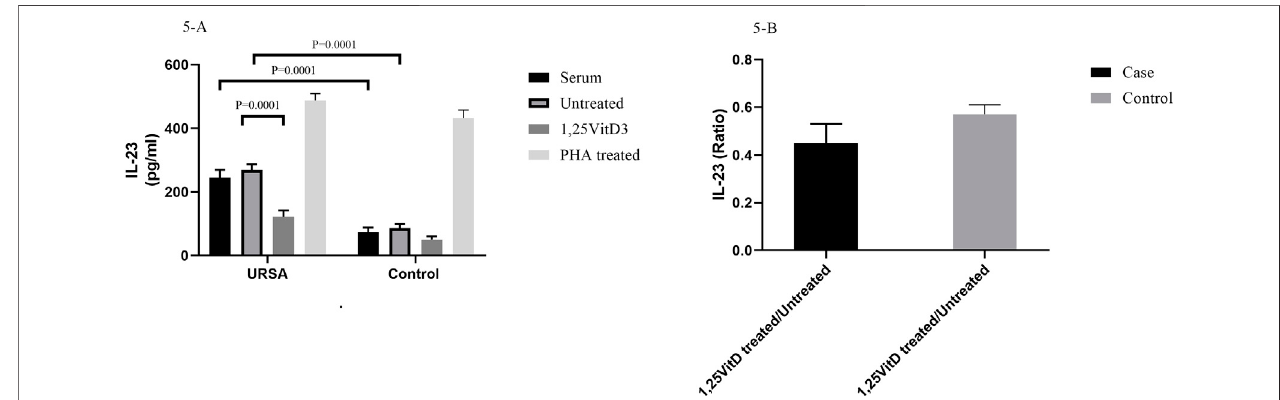
FIGURE5| IL-23levelsinserumandcellculturesupernatantsinwomenwithURSAandthecontrolgroup (A) .IL-23serumlevelswerehigherinwomenwithRSAthan in the control group. IL-23 levels were higher in cell culture supernatants in women with RSA than in the control group. 1,25VitD3 reduced IL-23 levels in the cell culture supernatants in women with URSA in comparison to the control group. (B) . IL-123 levels non-signi fi cantly decreased in women with URSA relative to the control group.